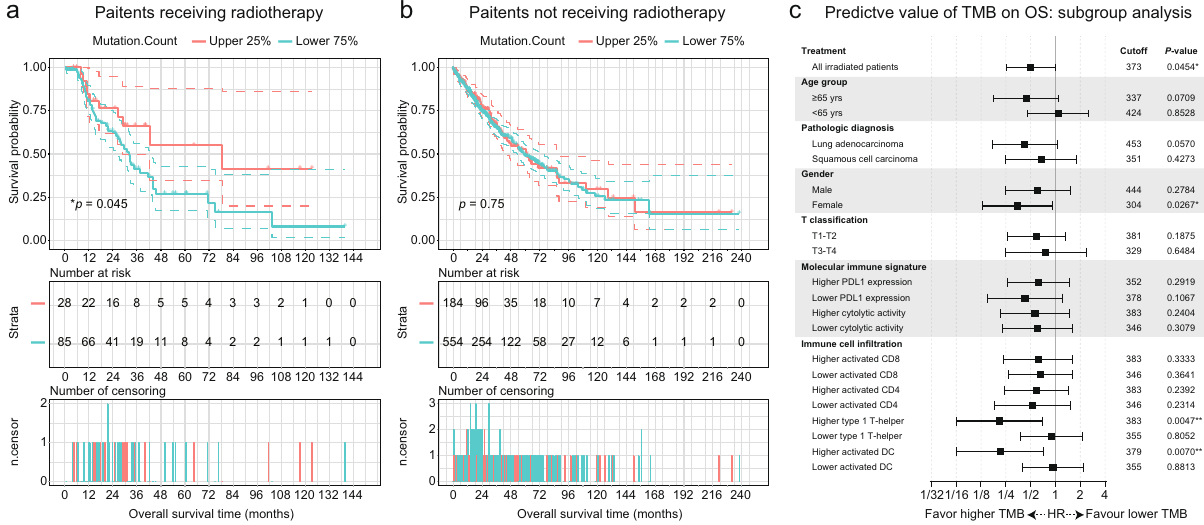
Fig. 1 Survival according to the presence of high or low tumor mutational burden within tumor. a, b Kaplan-Meier survival curves of OS (upper panel), table of number of risk (middle panel), and number of censoring (lower panel) according to the different mutational burdens for patients with ( a ) or without ( b ) radiotherapies. The hazard ratio (HR) was estimated by means of Log-rank test. 95% CI for HR was shown as colored dashed line. Red line, patients with higher TMB; blue line, patients with lower TMB. c Forest plot of TMB on OS for radiated patients, strati fi ed by demographics, molecular immune signatures, and immune cell in fi ltration. HRs comparing OS within each subgroup were showed in log2 scales. Bars represent the 95% CI. The upper 25% cutoff TMB for each subgroup as well as the two-sided Cox proportional regression p -value were displayed. The molecular immune signature and immune cell in fi ltration were grouped based on their median